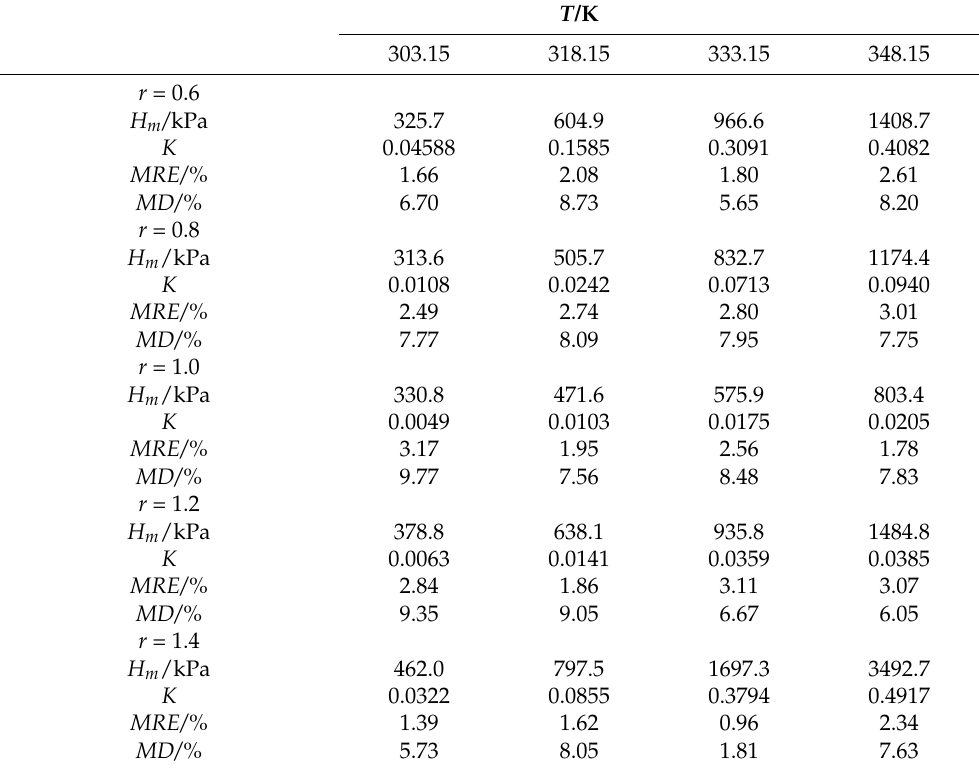
Table 2. Henry’s coefficients ( H m ) and equilibrium constants ( K ) obtained by RETM model fitting and the mean relative error ( MRE ) and maximum relative error ( MD ) between the experiments and the fitting values at temperature T a